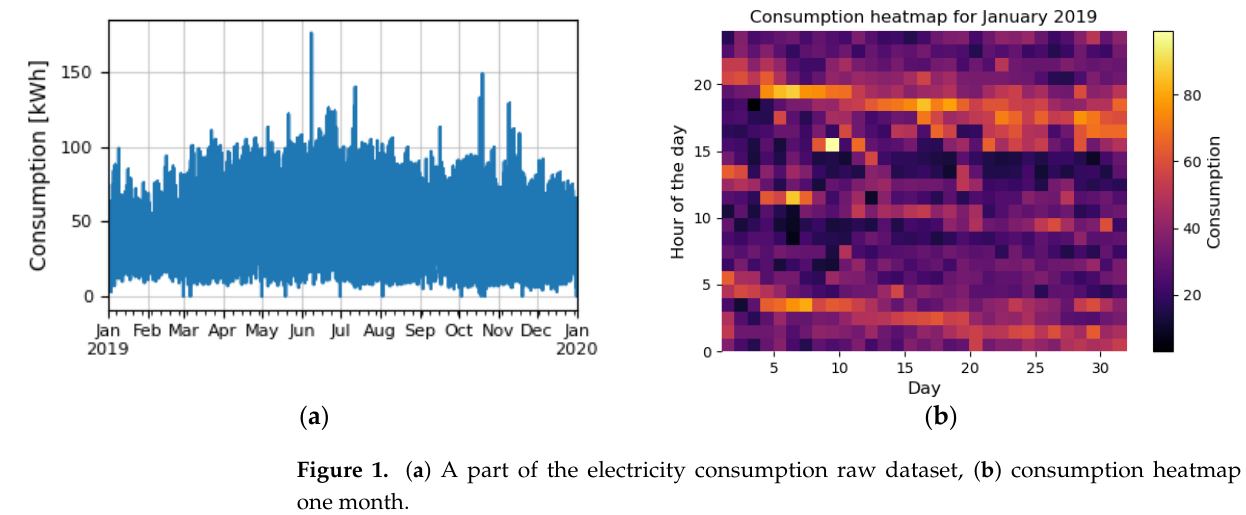
Figure 1. ( a ) A part of the electricity consumption raw dataset, ( b ) consumption heatmap for one month.